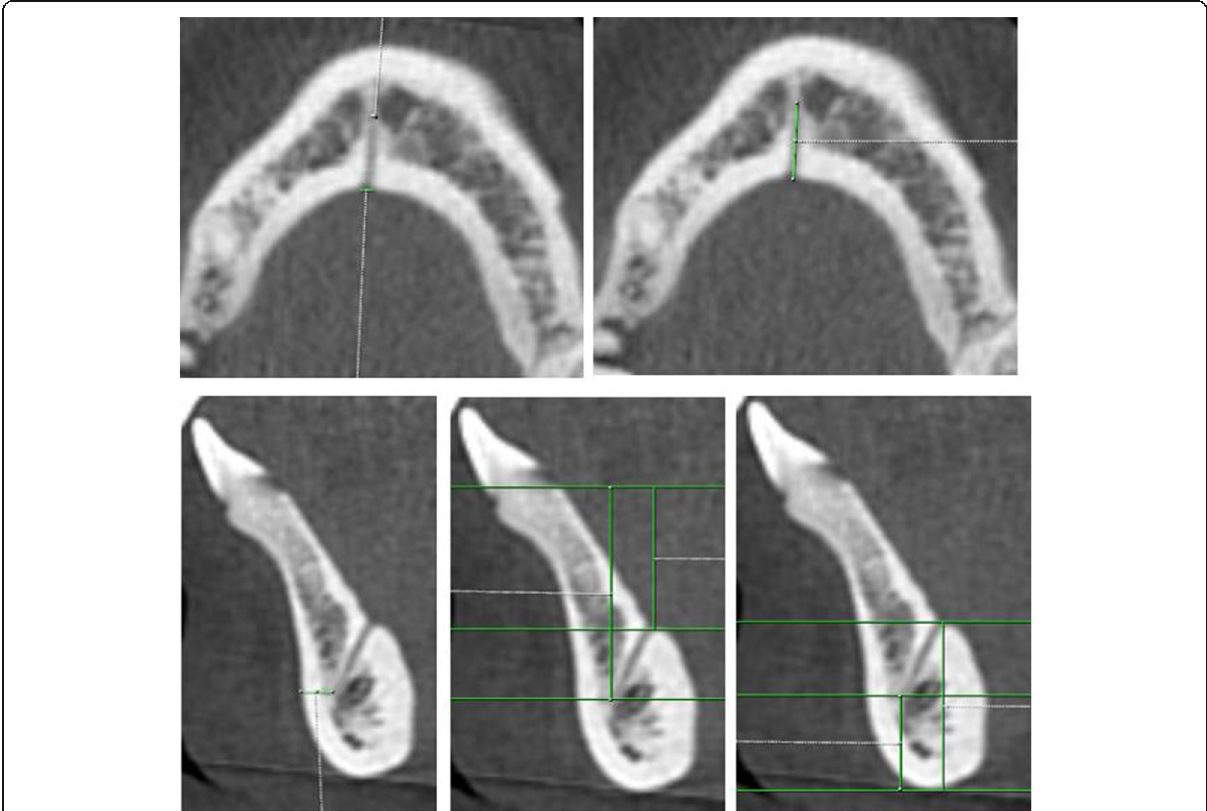
Fig. 4 CBCT measurements in 60-year-old female